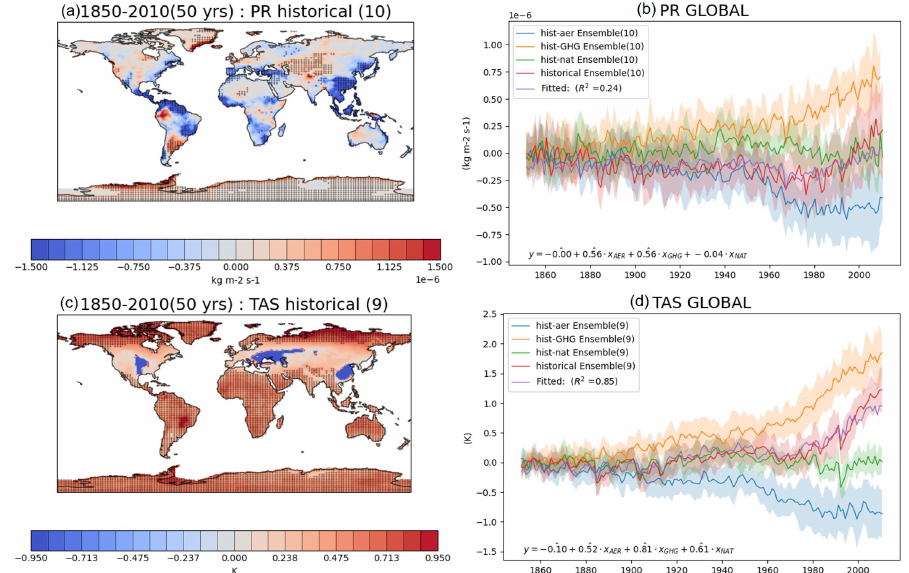
Figure 3. Results of precipitation (PR) and temperature (TAS) analyses: ( a ) 50-year mean start-to-end difference of precipitation; ( b ) time series plot of global precipitation; ( c ) 50-year mean start-to-end difference of temperature; ( d ) time series plot of global temperature. The titles above the plots and the legends within the plots are followed by the number of ensemble models in parentheses, and the estimated parameters with hats provide the statistical significance. On the maps, the dots indicate where the differences are significant ( p -value ≤